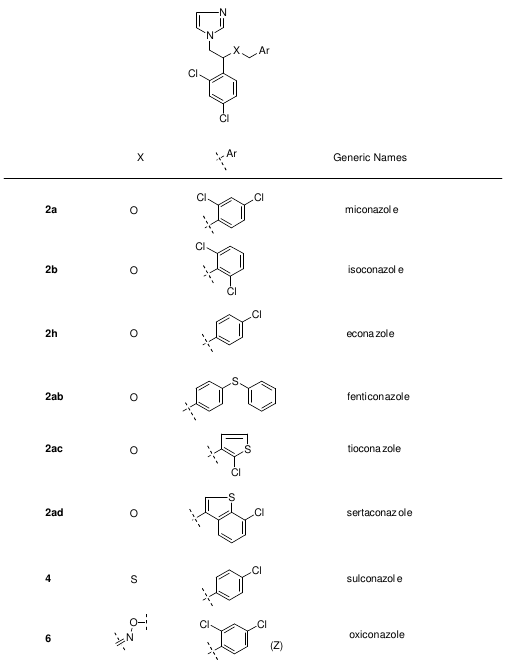
Figure 2. Miconazole and marketed